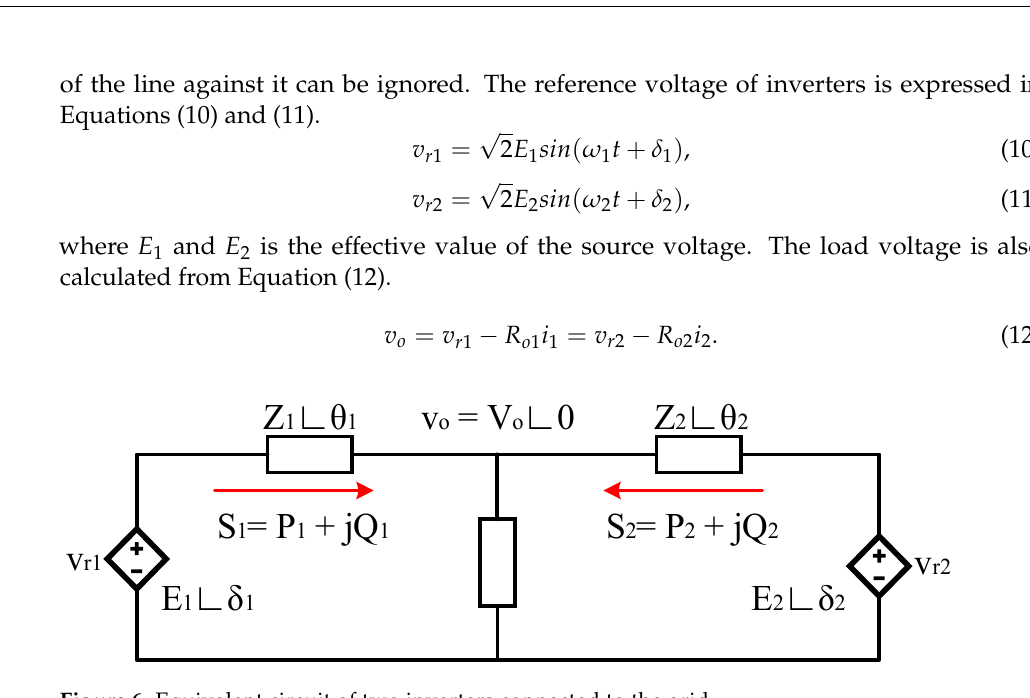
Figure 6. Equivalent circuit of two inverters connected to the grid.